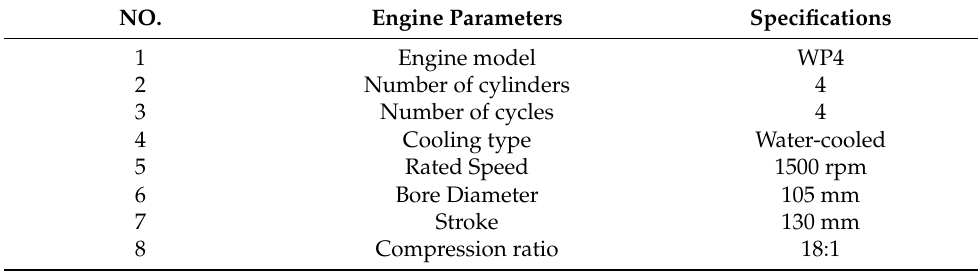
Table 3. Specifications of test engine.